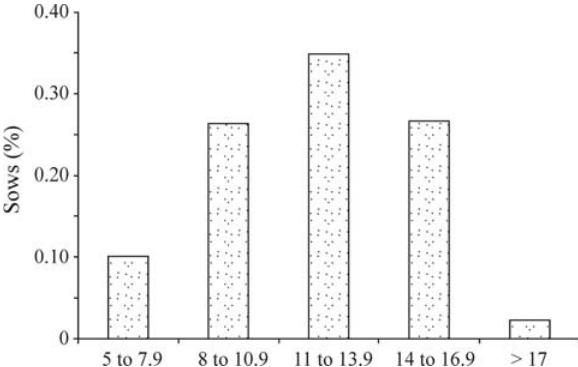
Figure3 -Distributionofanimalsaccordingtothemeannumberofpiglets per parity, considering a total of four parities, in sows of a commercial population from